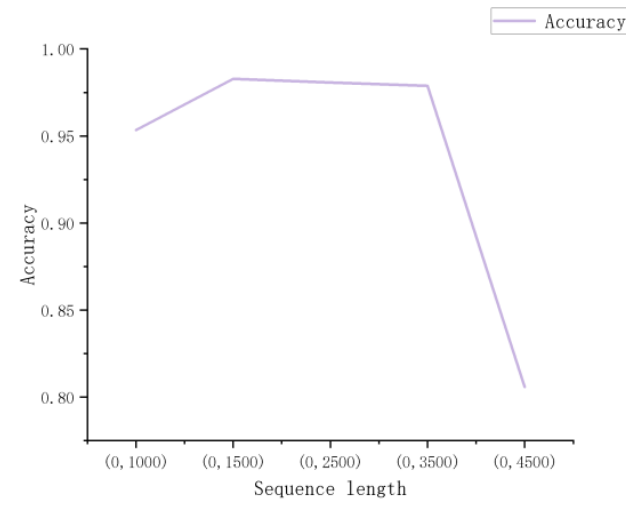
Figure 13. Sequence length selection experiment.